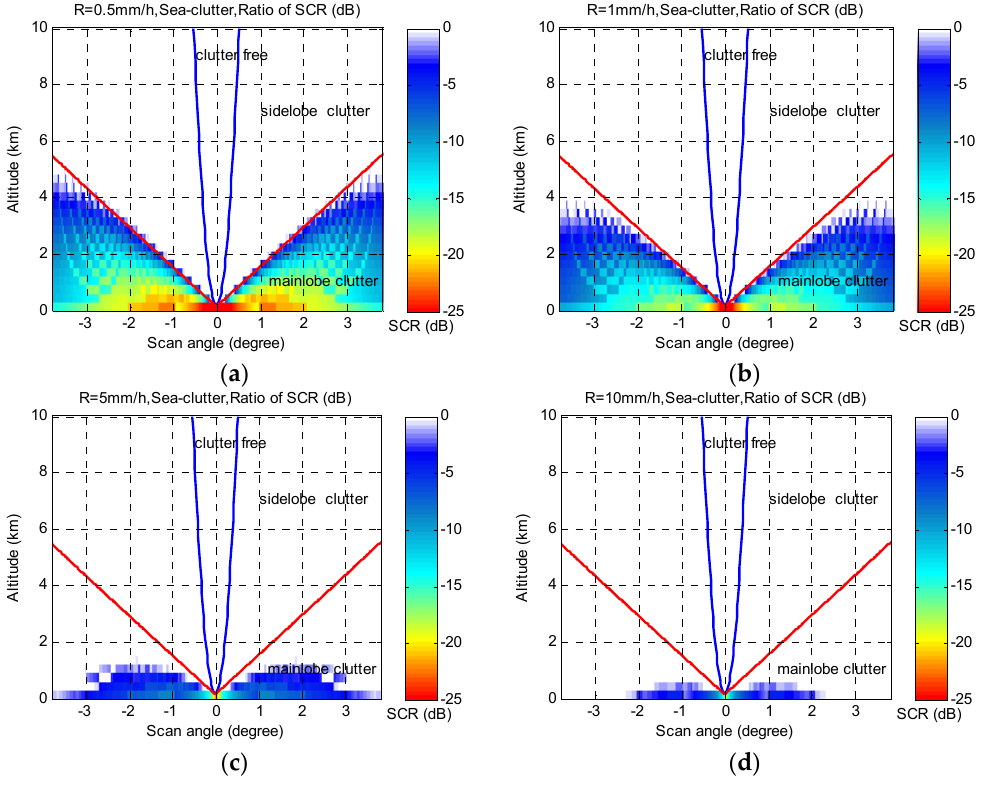
Figure 7. Power ratio of rain echo signal to sea surface clutter (SCR) with middle wind-speed of 10–15 m/s (NRCS data from APR2), under different spiral scan angles and different rain rates. The figures only show those SCR values below 0 dB; ( a ) 0.5 mm/h; ( b ) 1 mm/h; ( c ) 5 mm/h; and ( d ) 10 mm/h.